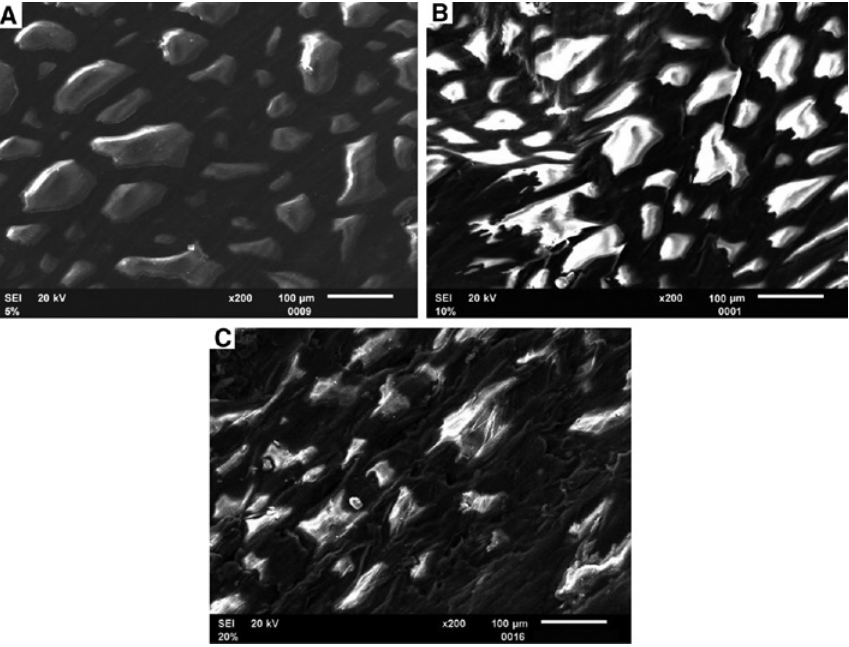
Figure 2: SEM micrographs of UHMWPE-based composites containing (A) 5, (B) 10 and (C) 20 wt% of carbon